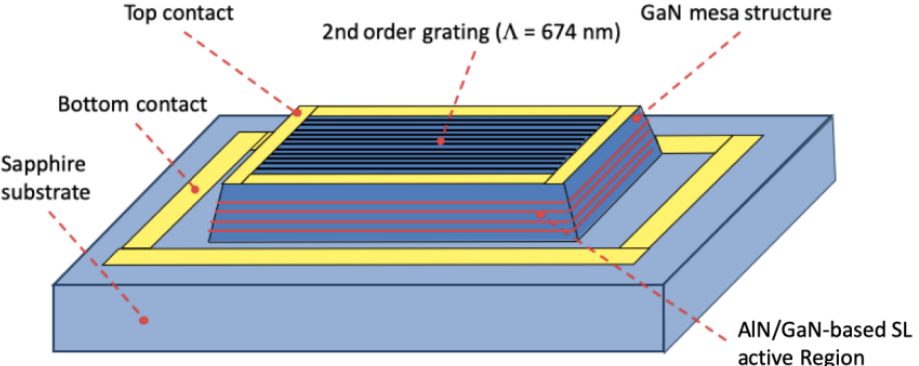
Figure 2. Schematic drawing of the square-shaped AlN/GaN-based inter-subband mesa with a diffraction grating on top. Metallization allows electrical contact at the top and the bottom of the mesa.